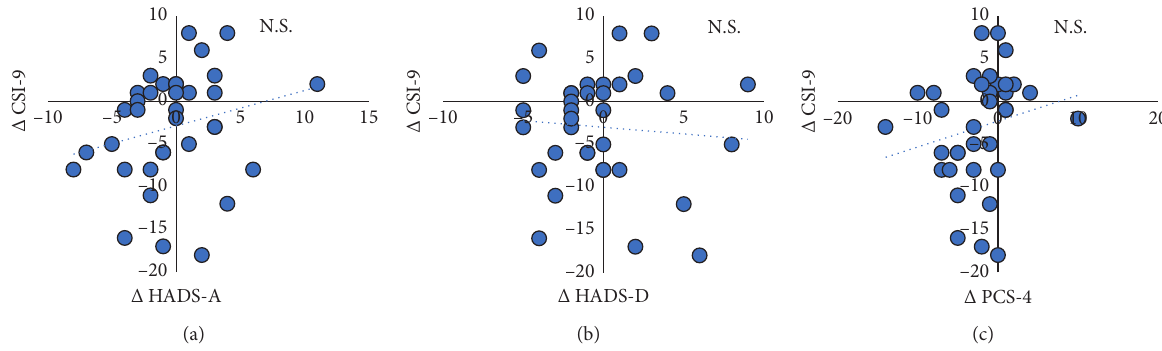
Figure 6: The correlation analysis and scatter plot of ∆ CSI-9 and ∆ HADS-A, ∆ HADS-D, and ∆ PCS-4. (a) The correlation analysis and scatter plot of ∆ CSI-9 and ∆ HADS-A. (b) The correlation analysis and scatter plot of ∆ CSI-9 and ∆ HADS-D. (c) The correlation analysis and scatter plot of ∆ CSI-9 and ∆ PCS-4. Abbreviations: CSI-9, Central Sensitisation Inventory-9; HADS-A, Hospital Anxiety and Depression Scale-Anxiety; HADS-D, Hospital Anxiety and Depression Scale-Depression; PCS-4, Pain Catastrophising Scale-4; ∆ , follow-up score minus the initial score.